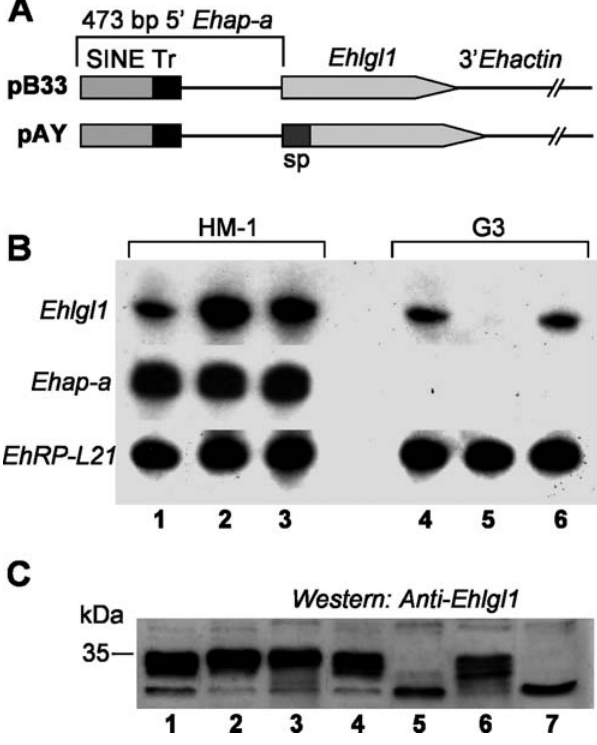
Figure 2. Silencing of the Ehlgl1 Gene (A) Diagrams of the Ehlgl1 -containing plasmids pB33 and pAY. The 473 bp Ehap-a promoter, SINE and T-rich (Tr) regions are marked. Plasmid pAY includes 44 bp of the signal peptide (sp) of the Ehap-a gene. Both plasmids contain the ORF of Ehlgl1 gene and the 3 9 regulatory sequence from the Ehactin gene. (B) Northern blot analysis of amoebic RNA extracts. Lanes: 1, untransfected HM1:IMSS; 2, HM-1:IMSS transfected with plasmid pB33; 3, HM-1:IMSS transfected with pAY; 4, untransfected clone G3; 5, clone G3 transfected with pB33; 6, clone G3 transfected with pAY. Blots were probed as indicated. (C) Western blot analysis of protein lysates separated on SDS-PAGE (12%) showing the blot that reacted with the polyclonal antibodies against the Lgl1 protein. Lanes 1–6 are as (B). Lane 7 contains lysate from the plasmidless RBV trophozoites (see Results). DOI: